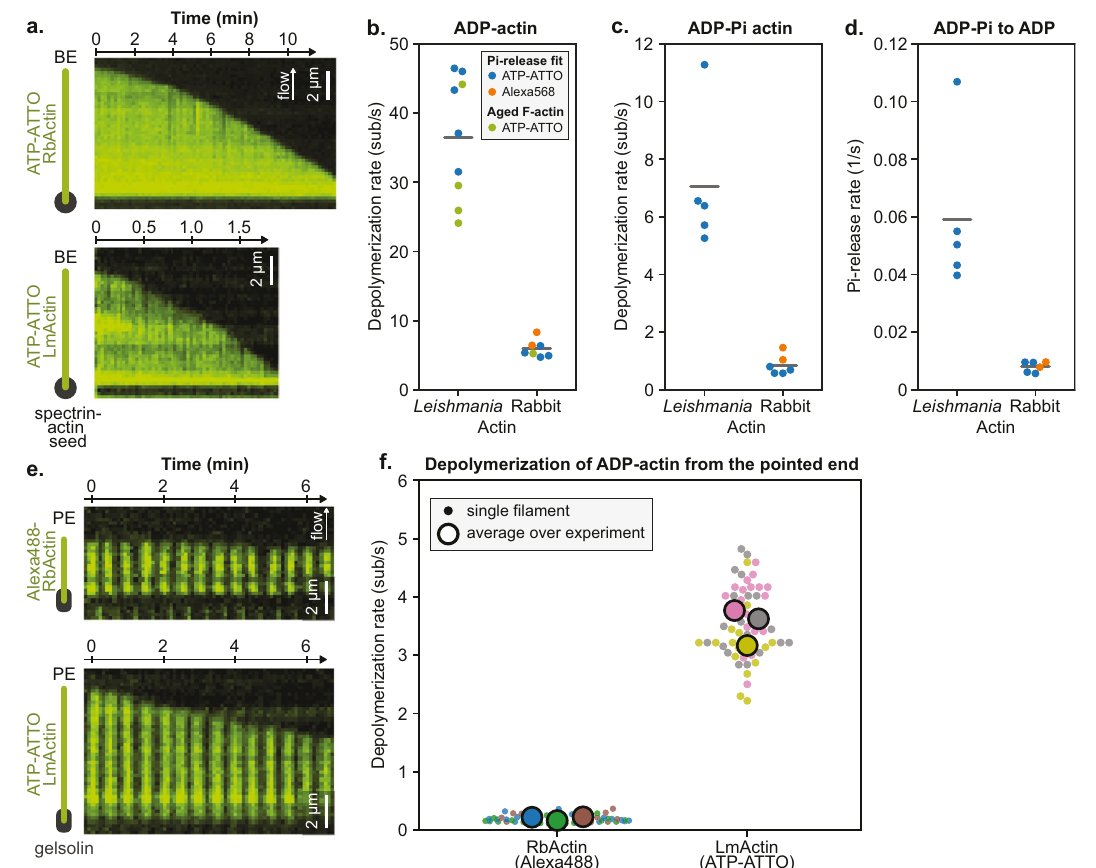
Fig. 2 Leishmania actin fi laments undergo rapid depolymerization from both ends. a Typical kymographs of RbActin and LmActin fi laments (visualized using ATP-ATTO-488) depolymerizing from their barbed ends. Actin subunits bear an ADP-Pi nucleotide at time t = 0, which is released over time to result in ADP-actin fi lament, as observed by the acceleration of the depolymerization rate. Note the difference in time scales between the RbActin and LmActin kymographs. b – d Comparison of the barbed end depolymerization rates of Leishmania and rabbit muscle ADP-actins (panel b ) and ADP-Pi-actins (panel c ), and the Pi-release rates of LmActin and RbActin fi laments (panel d ). Green symbols represent an average depolymerization rate of “ aged ” actin fi laments. Orange and blue symbols represent values obtained by fi tting the depolymerization rate of Pi-loaded actin fi lament vs. time over different data points of one movie (see Methods “ Pi-release fi t ” , see Supplementary Fig. 2b, c). Note that the RbActin labeling strategy, with either ATP-ATTO or Alexa568, does not affect the Pi-release rate. Each data point represents an average over all measured fi laments ( n ) from independent experiments ( N ), and lines correspond to the average over all experiments. N = 5 and n = 71, 25, 73, 58, 85 for Leishmania actin Pi-release; N = 4 and n = 81, 87, 60, 60 for rabbit actin Pi-release fi t with ATP-ATTO; N = 2 and n = 60, 60 for rabbit actin Pi-release fi t with Alexa568; N = 4 and n = 20, 20, 40, 40 for aged Leishmani a F-actin; N = 1, n = 20 for aged rabbit F-actin. e Typical kymographs of RbActin (labeled with Alexa488) and LmActin (ATP-ATTO) fi laments f Pointed end depolymerization rates of LmActin and RbActin actin. Each color depicts an independent experiment. Small data points describe